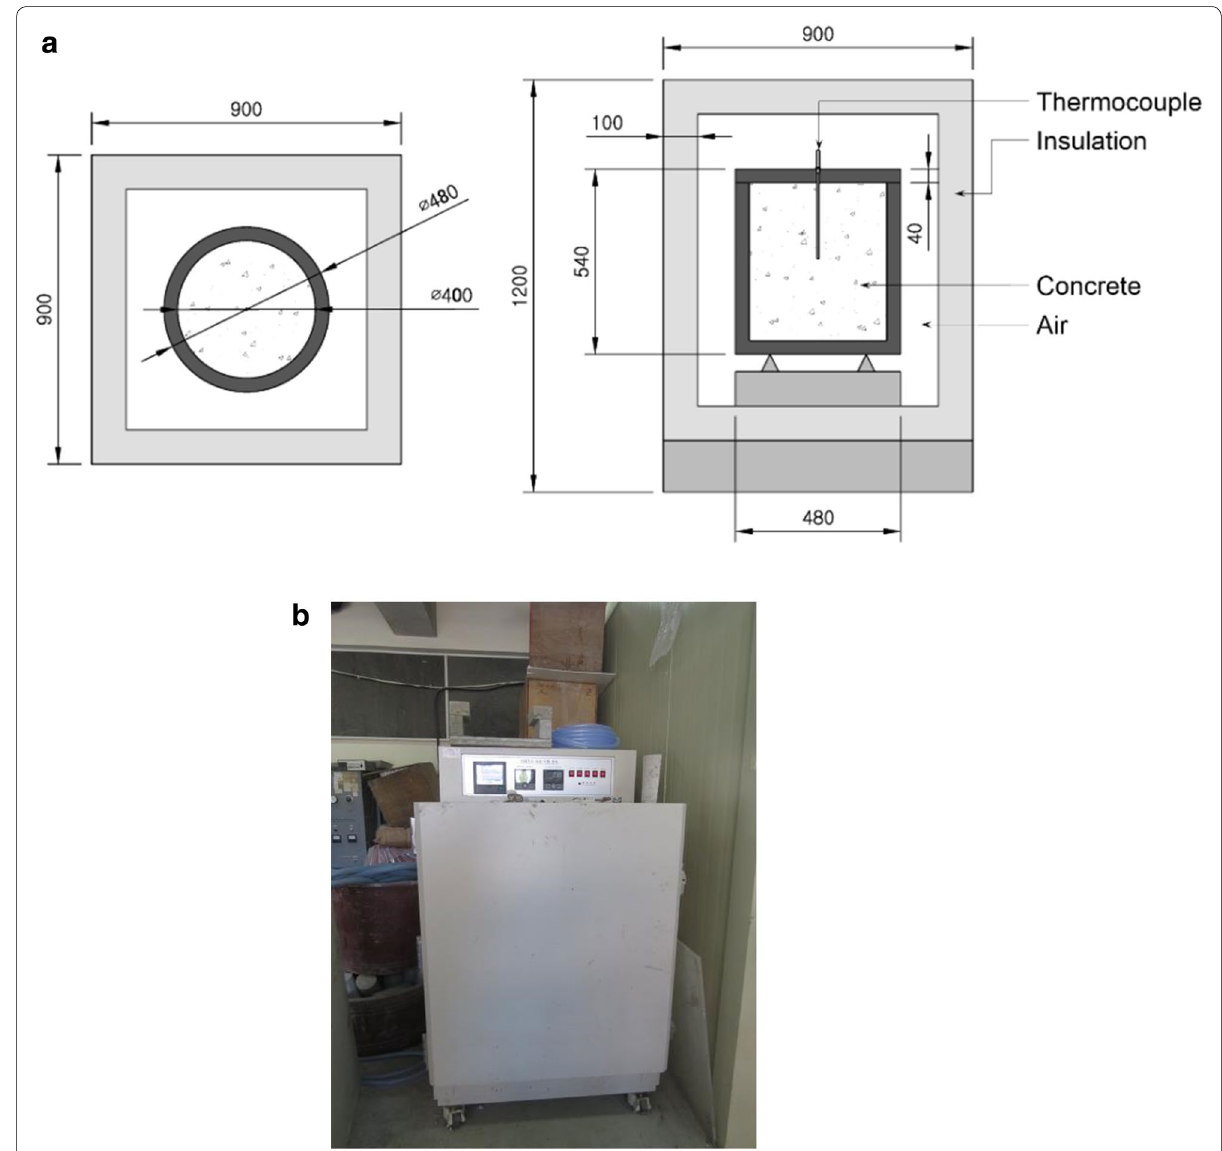
Fig. 1 Device for adiabatic temperature rise test. a Dimension [unit: mm], b test